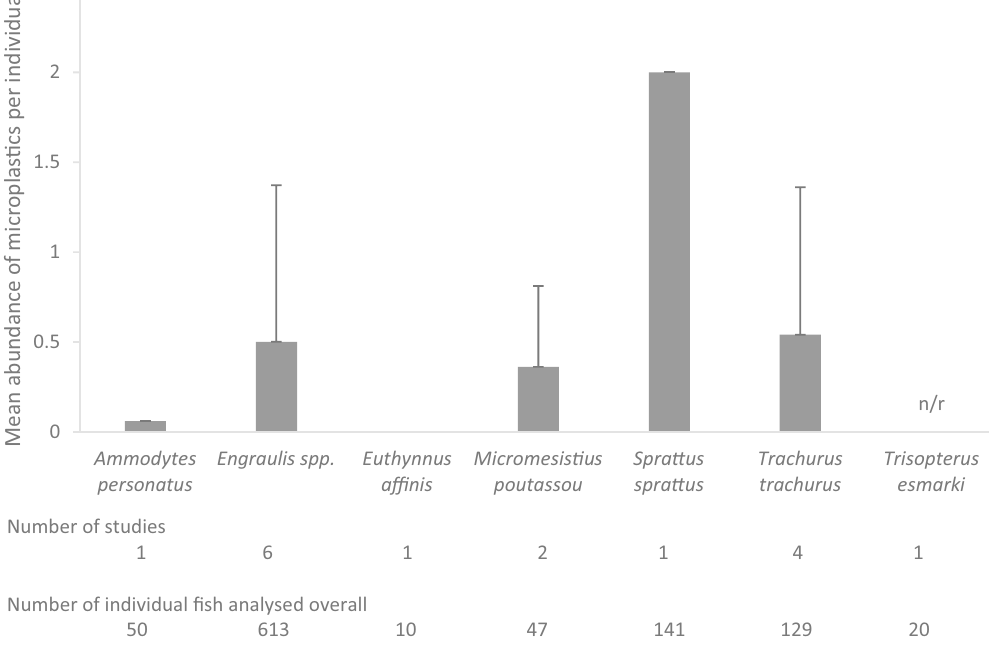
Figure 1. Mean abundance of microplastics per individual in studies assessing microplastics in fishmeal- relevant fish species. Only concentrations of ‘whole fish’ species used in fishmeal production are shown; 12 reviewed studies examined those species—four of those analysed two of such species each. n/r mean abundance was not reported. Error bars are 1× standard deviation of mean abundance per species of each